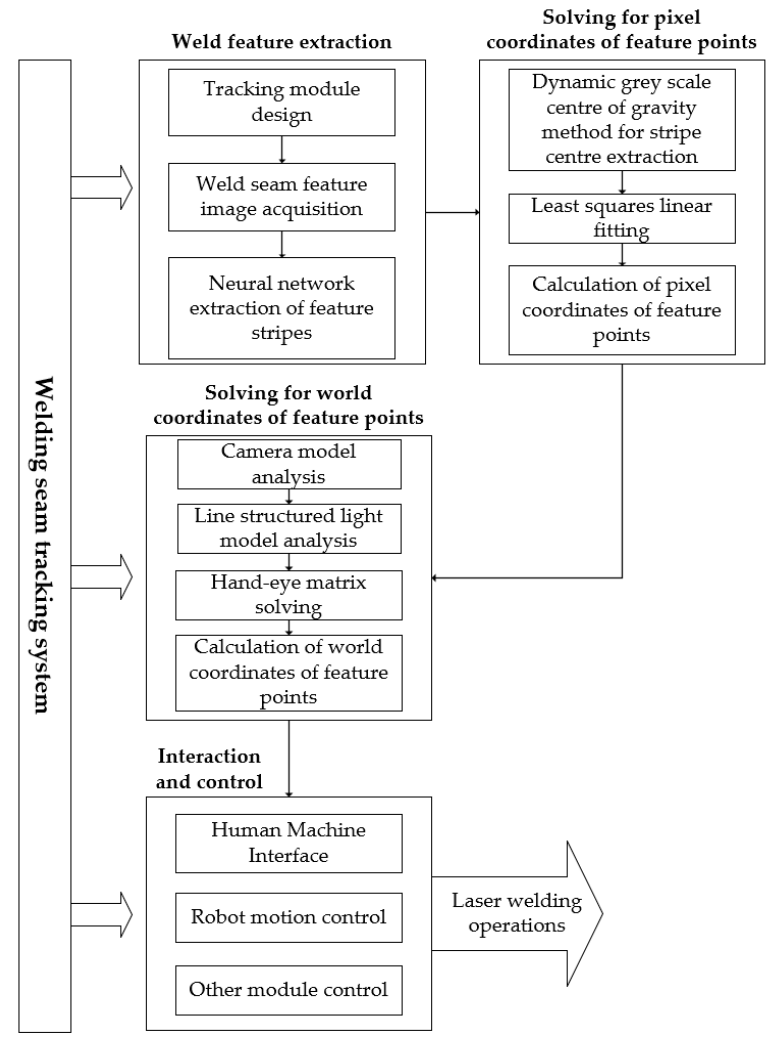
Figure 1. Overview of the weld streak extraction section in the weld tracking